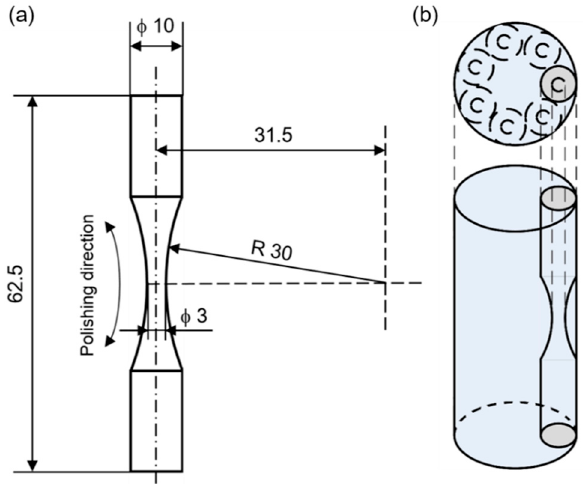
Figure 1. The geometry of specimen for fatigue tests: ( a ) Sketch map (unit: mm); ( b ) the positions of specimens in the hot-rolled bar.